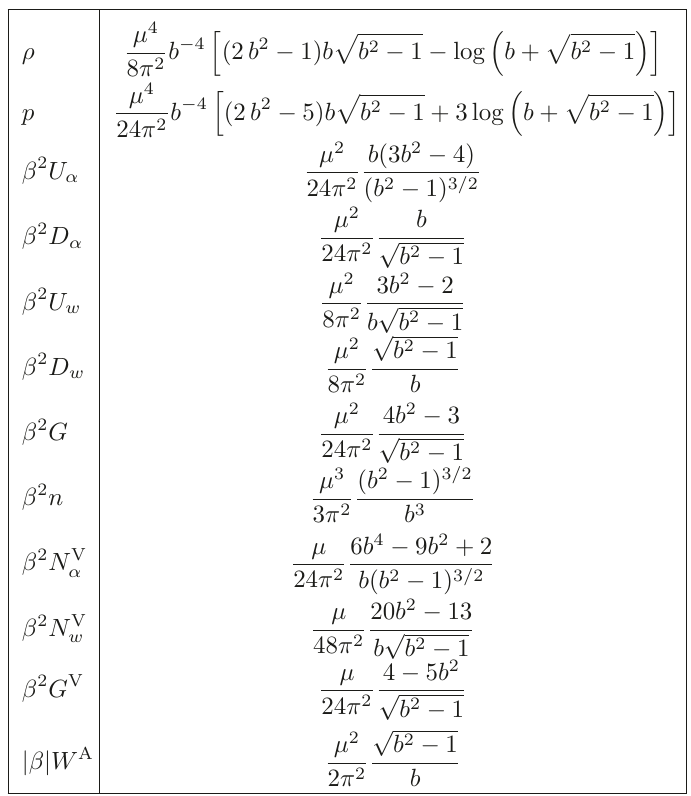
Table 5 . The coefficients of the energy momentum tensor (5.3), the vector current (6.3) and axial current (7.1) for the Dirac field at T = 0 and finite chemical potential µ , where b = µ/m